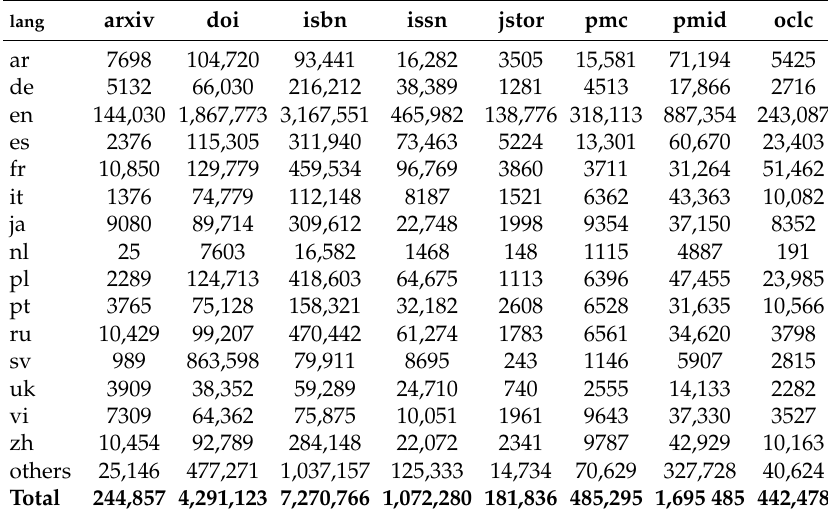
Table 1. Number of references with particular identifier in Wikipedia articles in various language versions. Source: own calculations in November